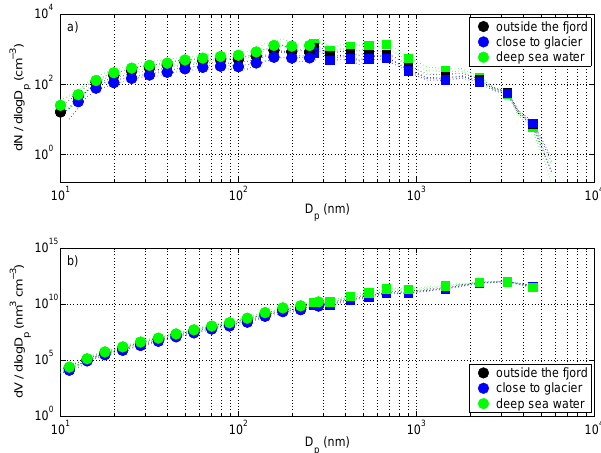
Fig. 12. (a) Comparison of median particle number size distri- butions for different sea water types. (b) Comparison of median particle volume size distributions. Dashed lines represent the 25th and 75th percentiles. The part of the size distribution measured by DMPS is marked with circles, whereas the part measured by OPC is marked with squares. Only every second data point is shown for